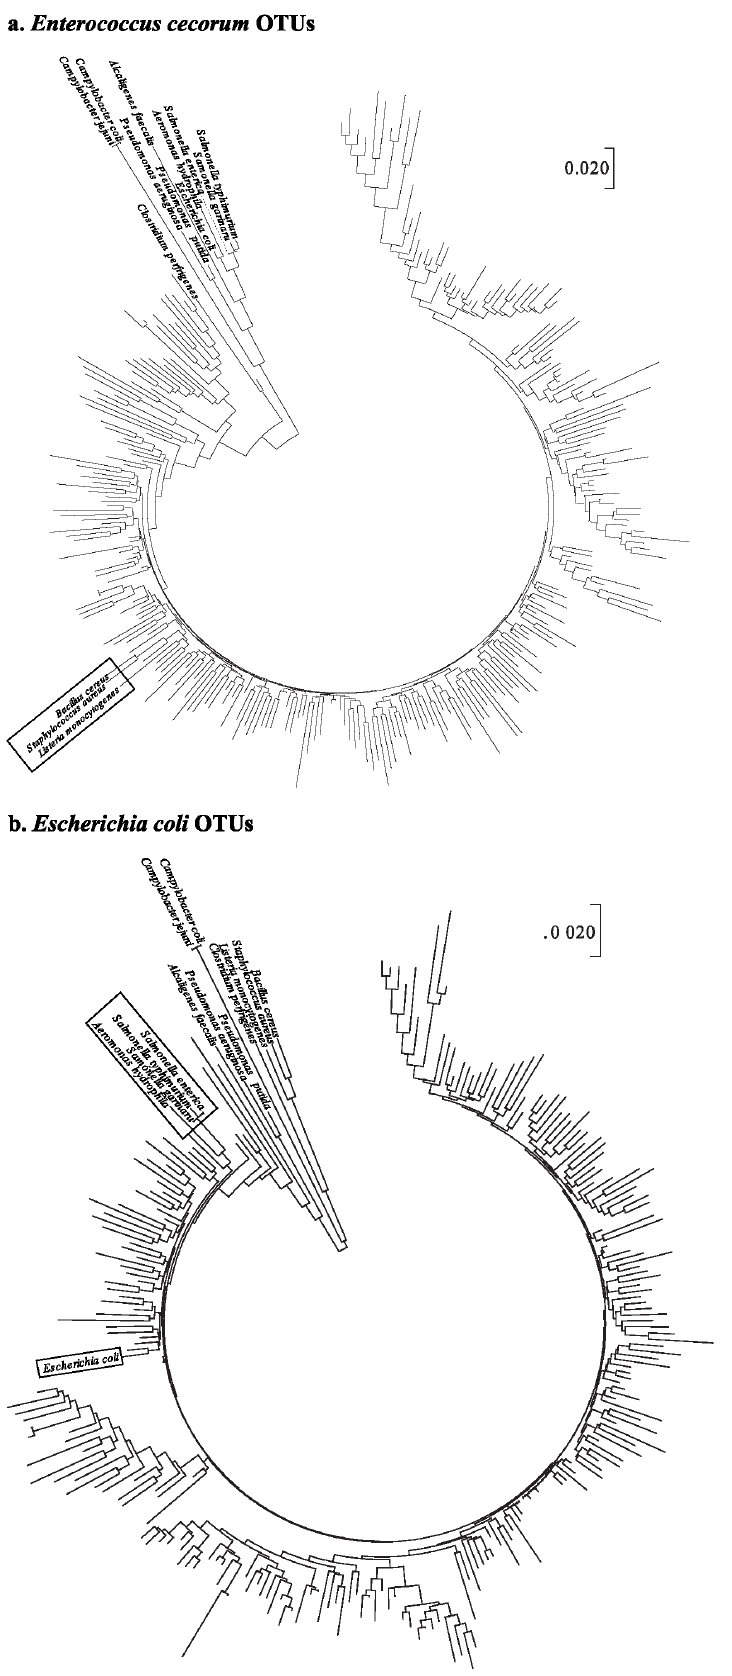
Figure 1. Phylogenetic trees constructed using the neighbor-joining method based on the nucleotide sequences of 14 pathogens. Operational taxonomic units sequences were assigned to (a) Enterococcus cecorum and (b) Escherichia coli. The phylogenetic tree was constructed from MEGA